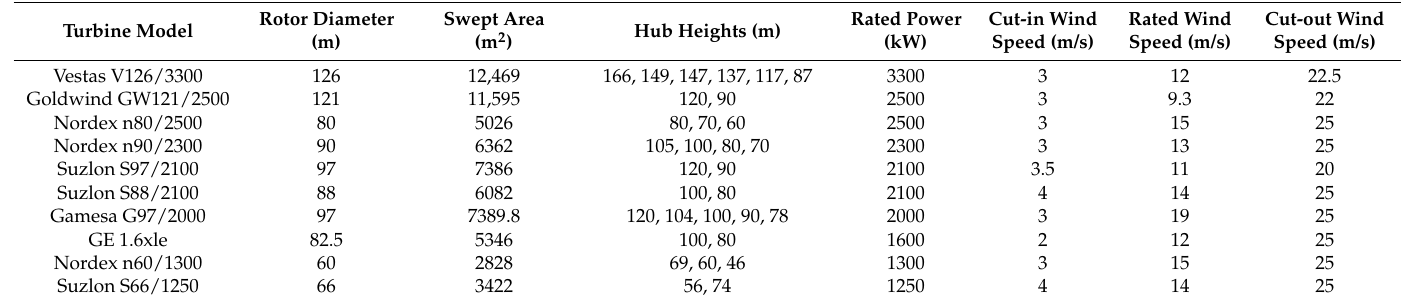
Table 4. Wind turbine characteristics used in this study.